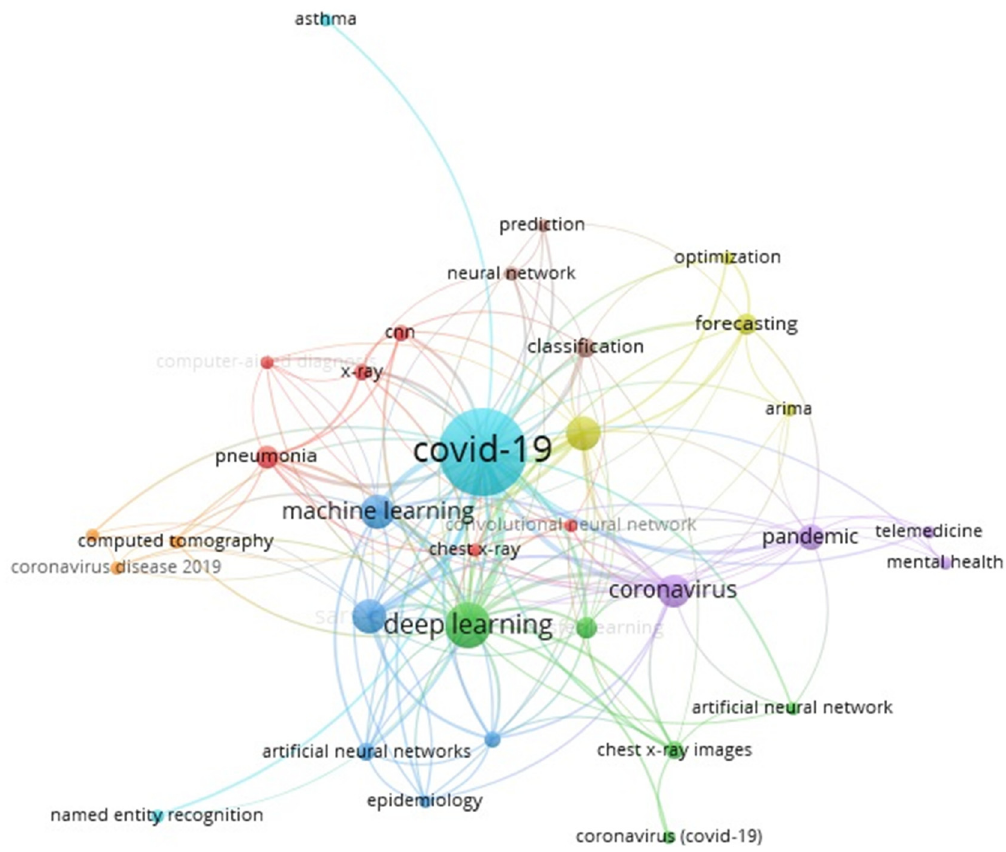
Figure 9: Keywords found in the literature related to COVID - 19